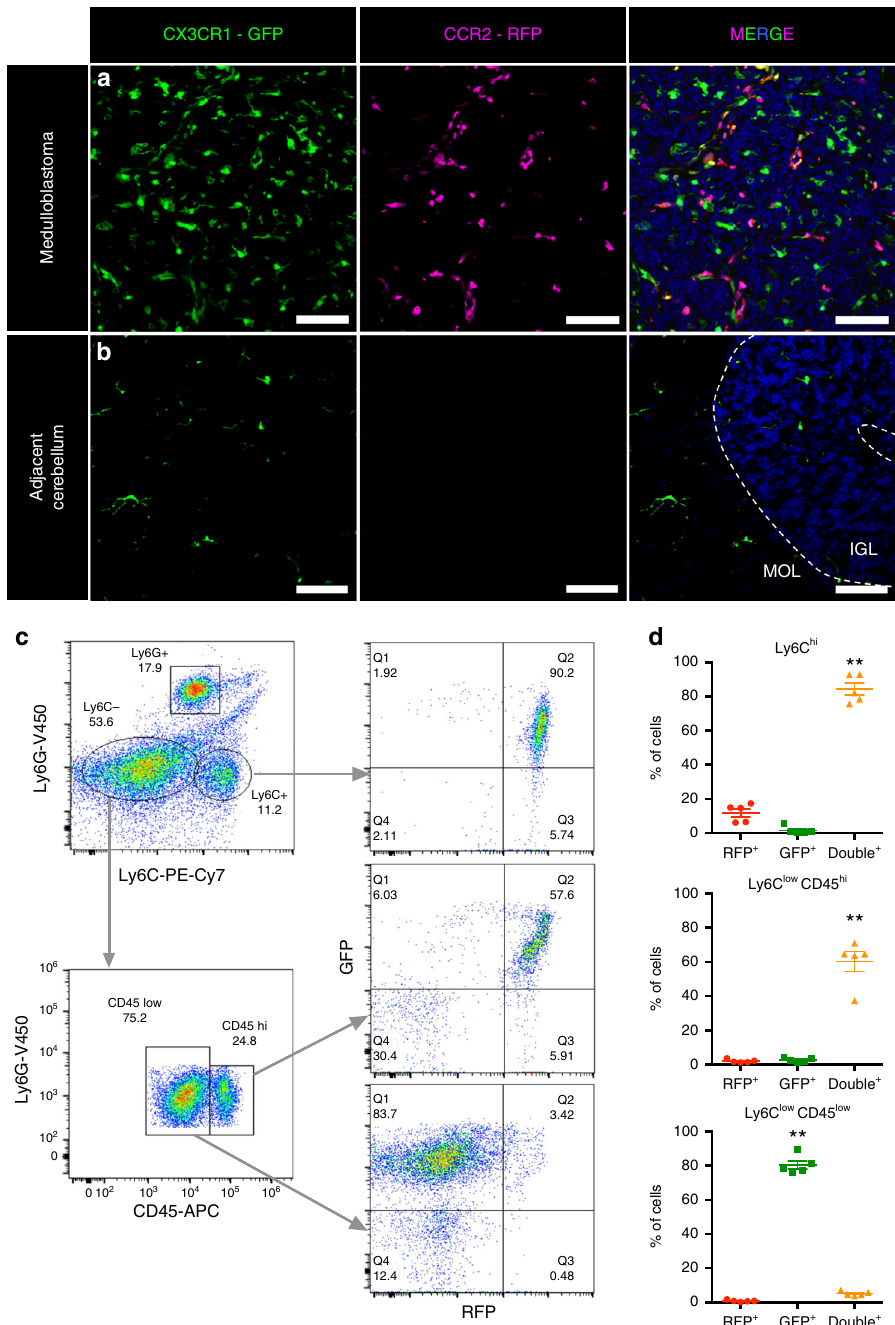
Fig. 2 TAMs in medulloblastoma are predominantly of myeloid origin. a , b Direct fl uorescent visualisation of SmoA1 orthotopic allograft in Cx3cr1 + /GFP ; Ccr2 + /RFP mouse model revealed the presence of leukocytes in tumour area ( a ), but not in adjacent cerebellum ( b ). Green – GFP, Magenta – RFP, Blue – DAPI. Scale bars represent 100 µ m; data are representative of at least fi ve independent experiments. c Flow cytometry gating strategy for analysis of immune-cell types in tumours from Cx3cr1 + /GFP ; Ccr2 + /RFP mice. Ly6C – monocyte marker, Ly6G – neutrophil marker, CD45 – myeloid immune-cell marker. d Quanti fi cation of data plotted in c , mean ± S.E.M., N = 5, one-way ANOVA with multiple comparisons, ** P <